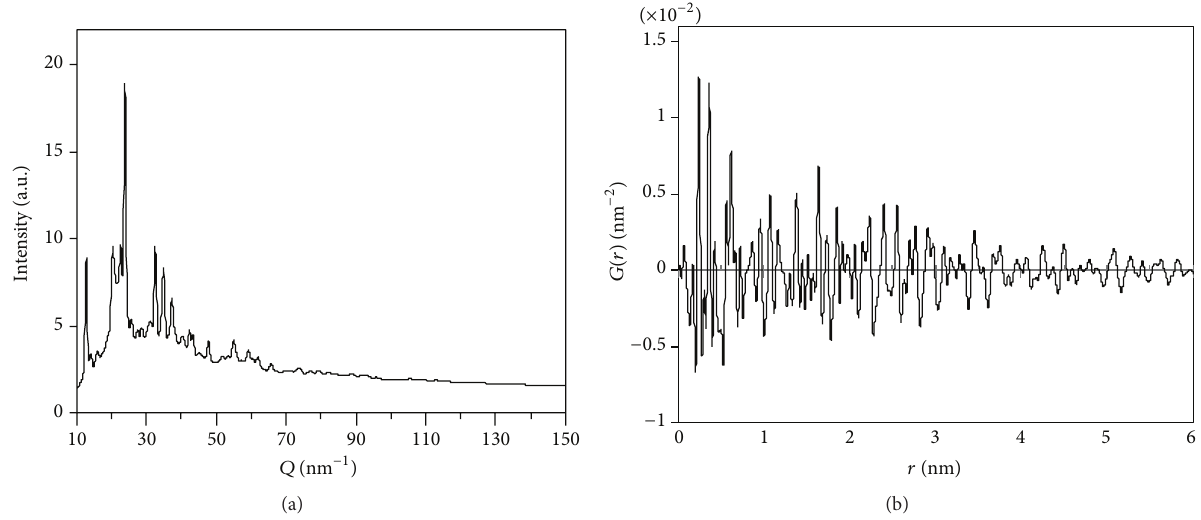
Figure 1: (a) X-ray diffraction pattern of PC paste measured at the detector position of 300 mm and (b) the PDF data derived from the diffraction pattern shown in